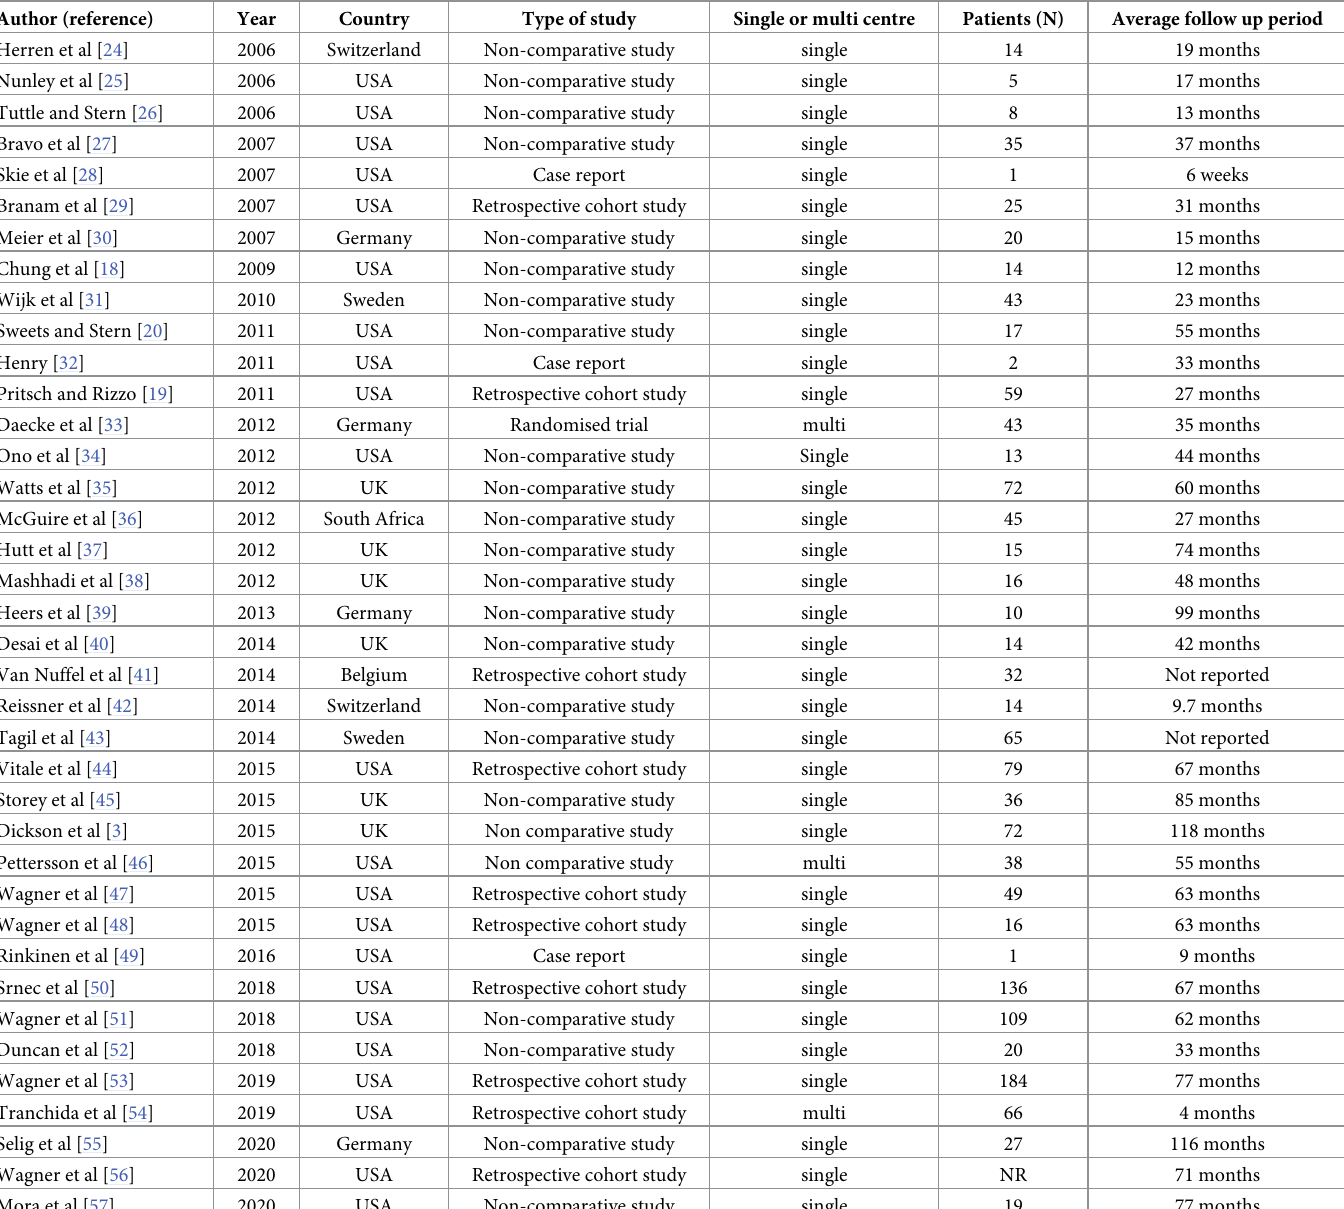
Table 1. Characteristics of included